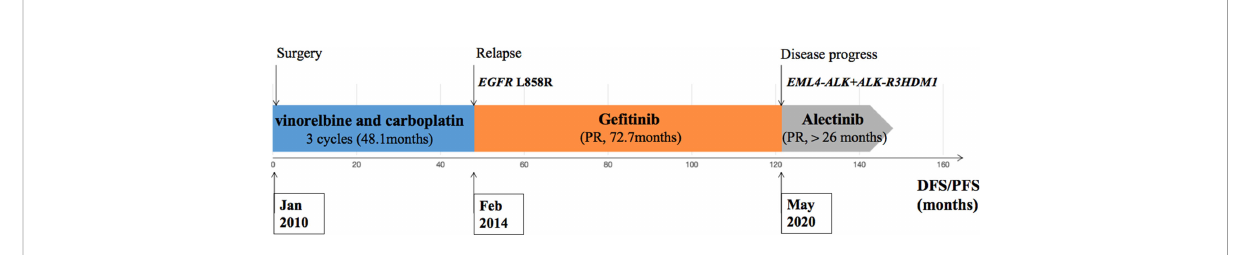
FIGURE 4 Description of the clinical course and pertinent molecular fi ndings for the patient presented.